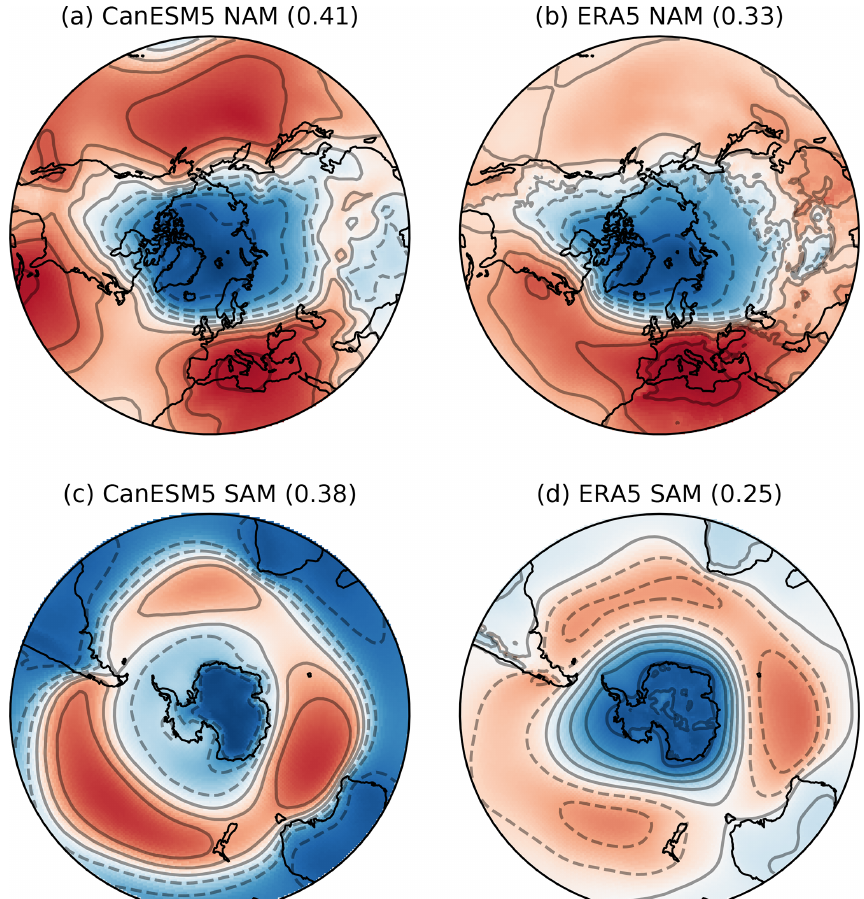
Figure 24. First empirical orthogonal functions (EOFs) of sea-level pressure north of 20 ◦ N (a, b) and south of 20 ◦ S (c, d) , representing the Northern Annual Mode (NAM) and Southern Annular Mode (SAM), respectively. The NAM is based on the extended winter DJFM season, and the SAM is based on monthly sea-level pressure. Results are shown for CanESM5 (a, c) and ERA5 (b, d) , and the amount of variance explained by each EOF is given in